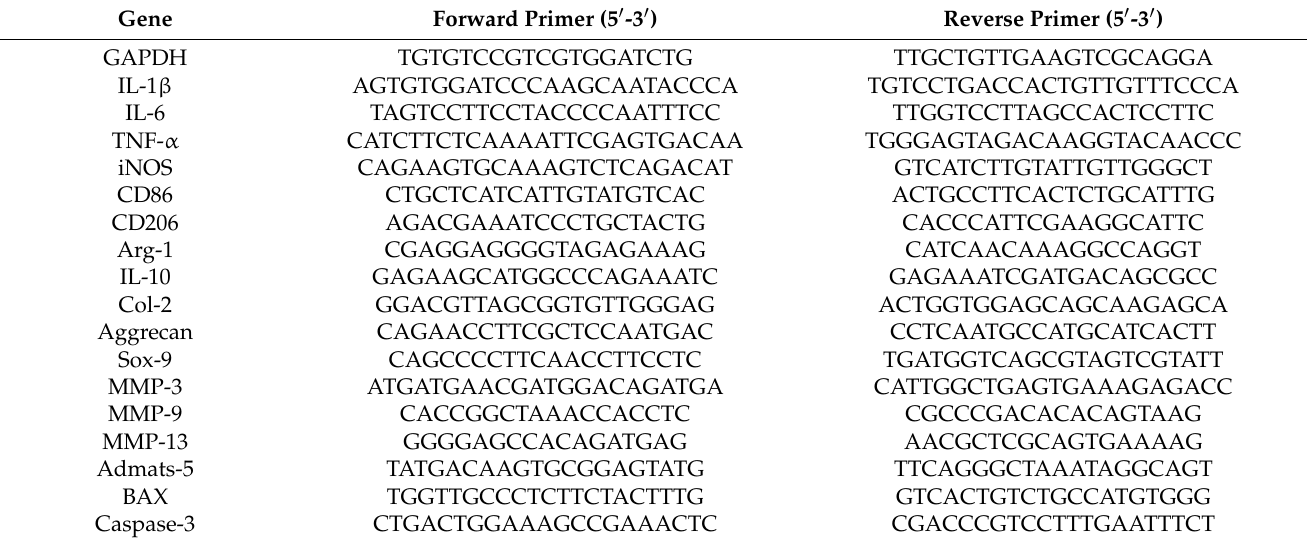
Table 1. Primers used for